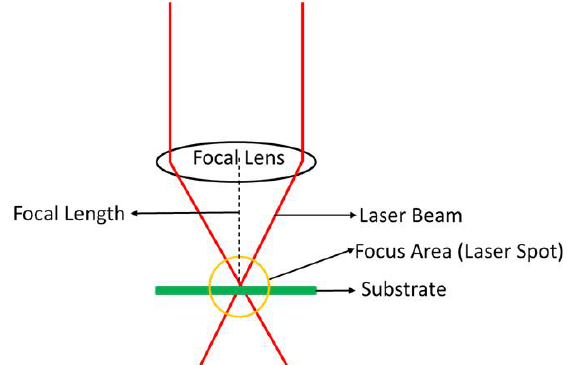
Figure 3. Schematic of laser focused on the top surface of the substrate both in LBMM and LA-LBMM processes.